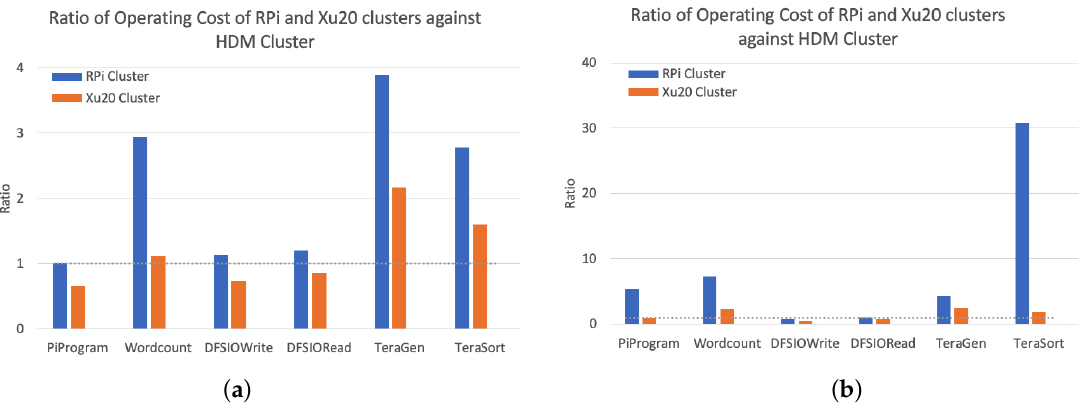
Figure 9. Ratio of operating cost (dollars) of RPi and Xu20 Clusters against HDM Cluster with: ( a ) lowest parameter settings; and ( b ) highest parameter